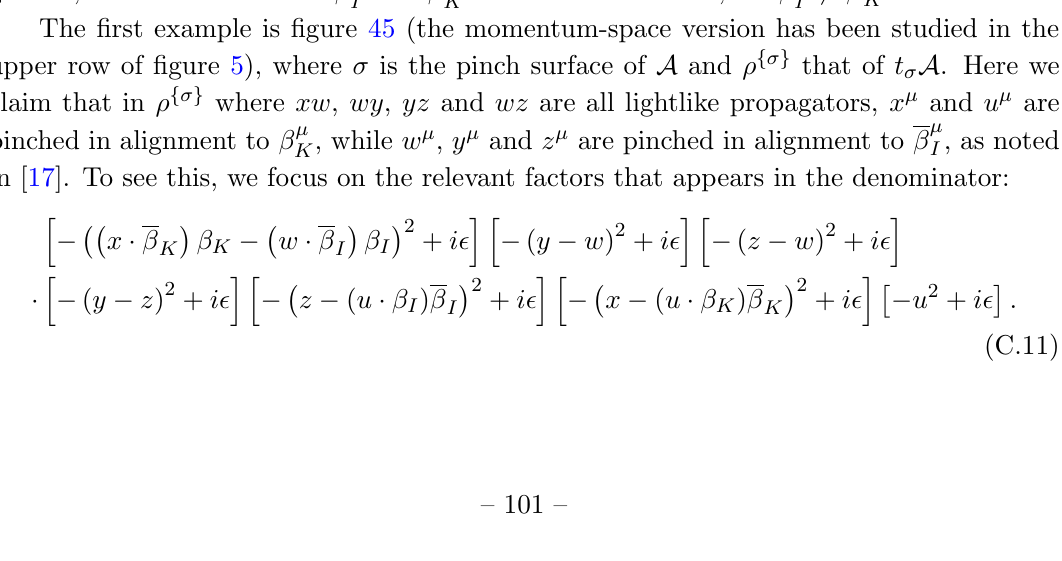
(cid:22) rather than (cid:12) (cid:22) in (cid:26) f (cid:27) g I K